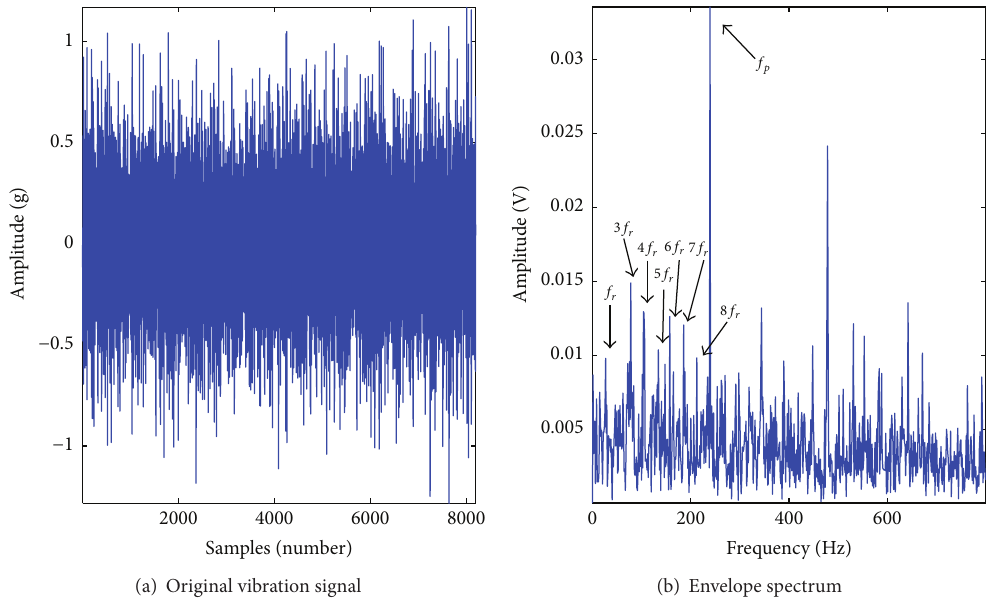
Figure 2: Original signal and envelope spectrum of bearing with inner race fault.